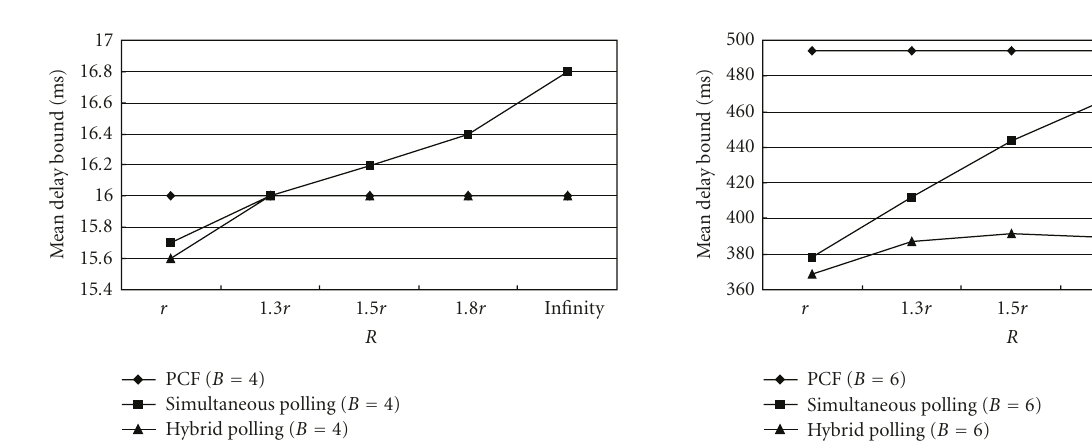
Figure 12: Mean delay bounds when the heavy tra ffi c load ( B = 6) is imposed on IEEE 802.11a wireless LAN with 40